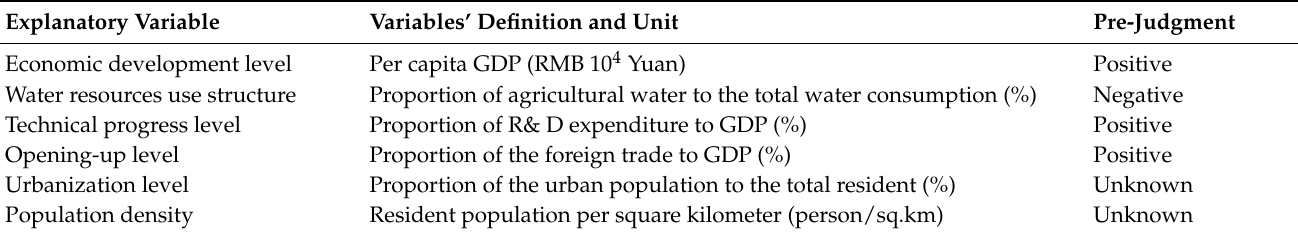
Table 2. WSGUE assessment